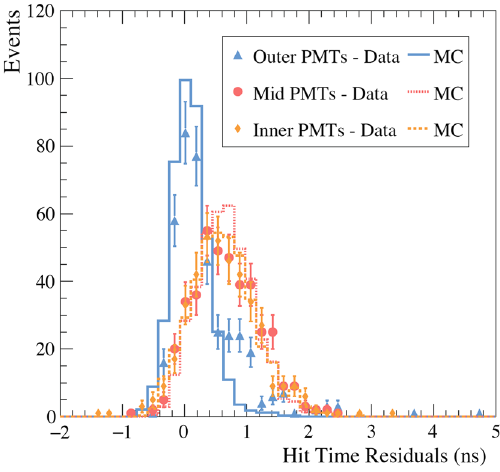
Fig. 10 Hit-time residual distributions in LAB/PPO for data and MC